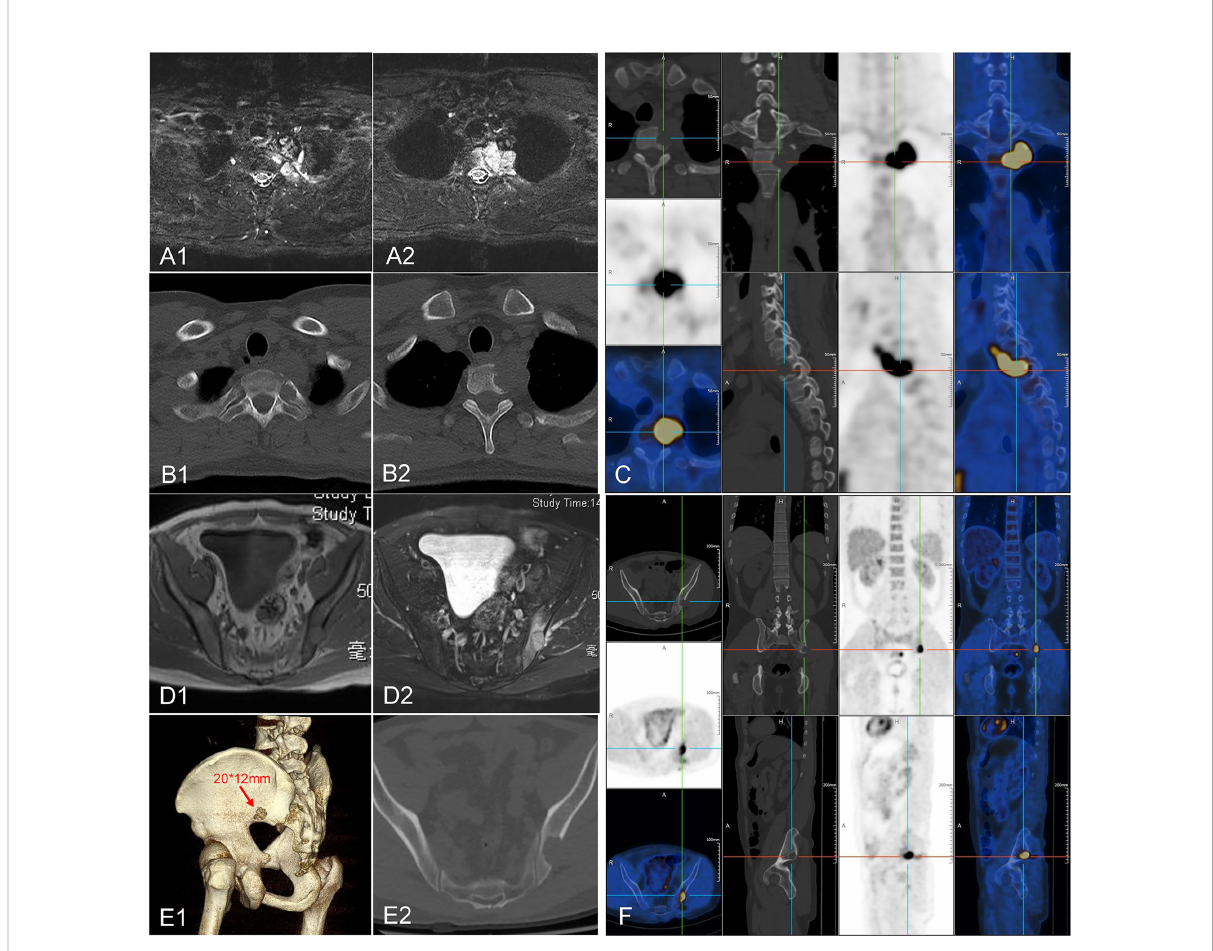
FIGURE 1 Image of the neoplastic lesions. (A – C) Neoplastic lesions found on the left side of C7-T2 invading the vertebrae body of T1, T2, and caput costae of the second rib. (D – F) A suspected metastasis was found in the left